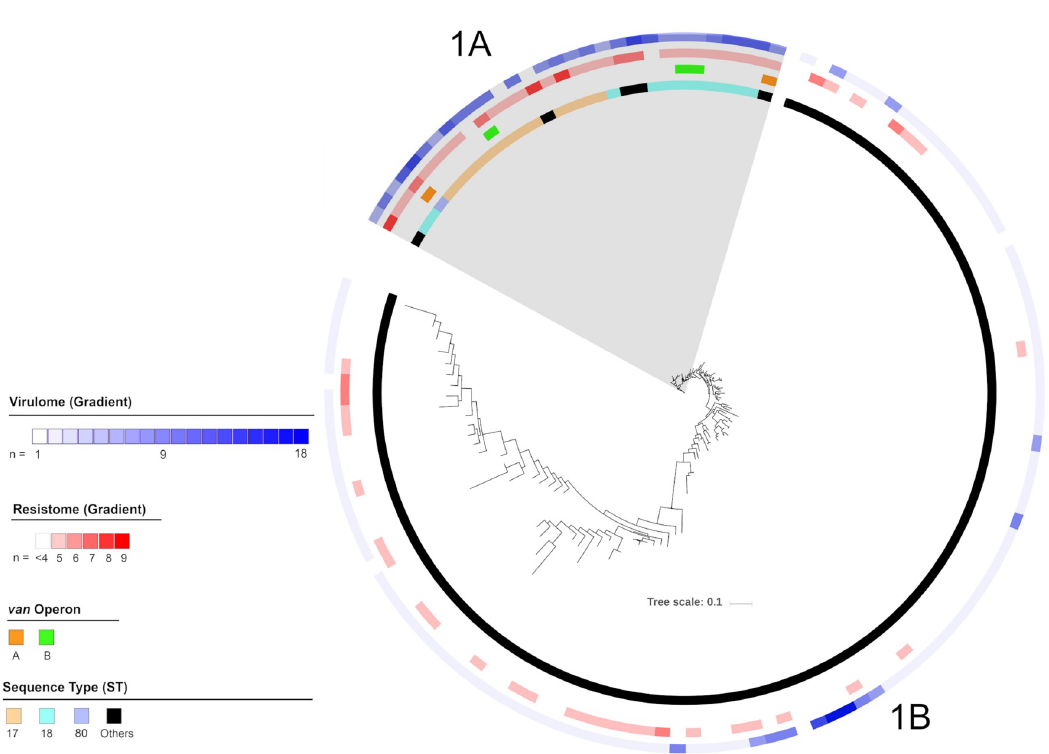
Fig 2. Maximum likelihood phylogenetic tree of cluster 1 isolates. From the outermost ring: Number of virulence factors, number of resistance genes not including the van operon, type of van operon and sequence types are highlighted as per legend.